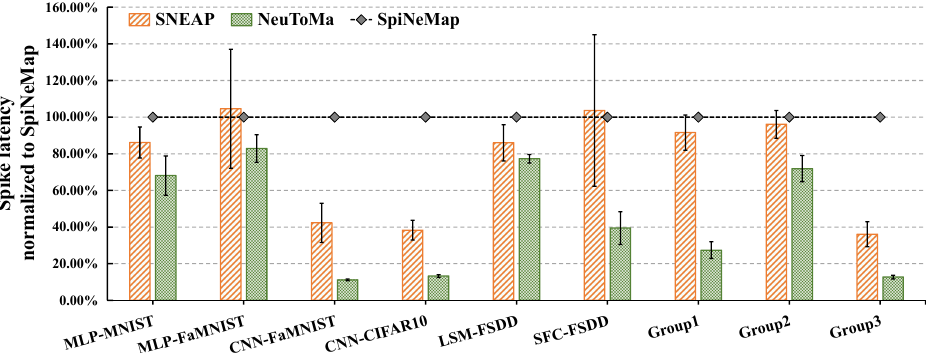
Figure 10. Spike latency normalized to SpiNeMap.